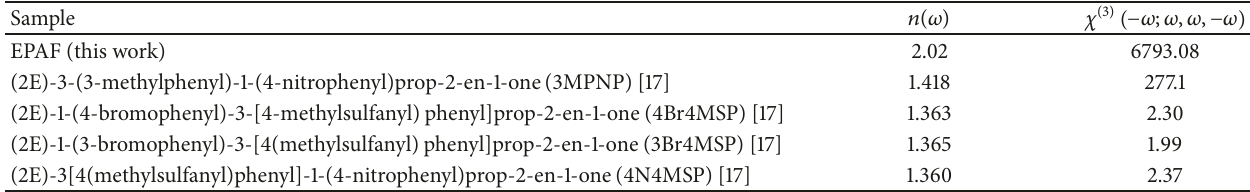
Table 6: DFT/CAM-B3LYP/ 6-311++ 𝐺(𝑑, 𝑝) results for the linear refractive index and third-order nonlinear susceptibility (10 −22 𝑚 2 /𝑉 2 ) for the case dynamic ( 𝜆 = 532 𝑛𝑚 ) of the EPAF crystal.